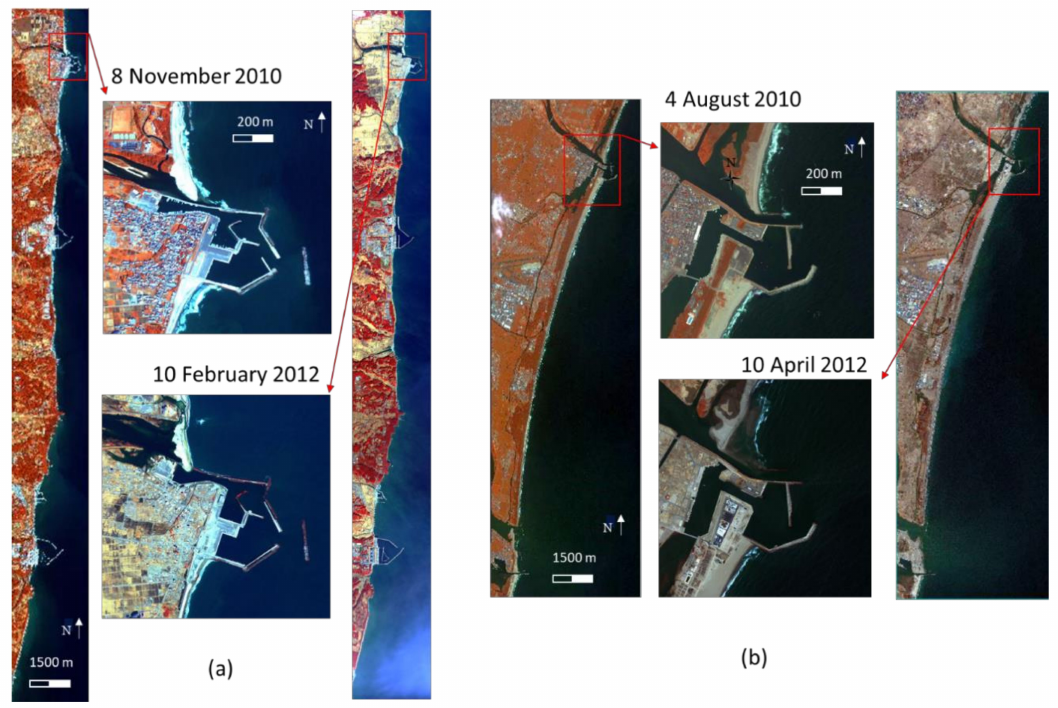
Figure 2. The southern and northern areas listed as two red boxes in Figure 1: ( a ) Worldview-2 images of the southern area acquired before (8 November 2010) and after the tsunami (10 February 2012), with a visual focus on the Ukedo harbor. ( b ) Worldview-2 images of the northern area acquired before (4 August 2010) and after the tsunami (10 April 2012), with a visual focus on the Yriage harbor.